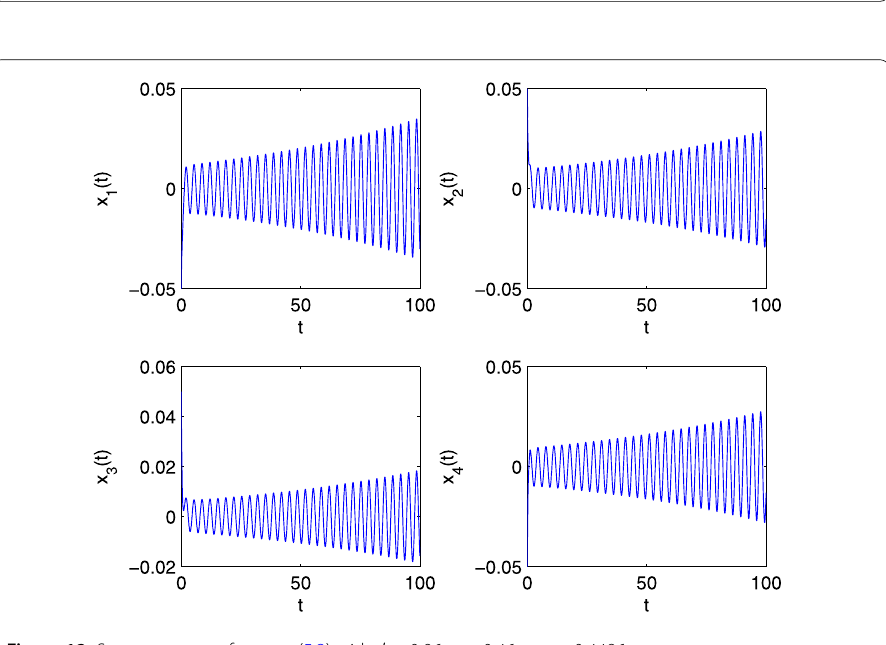
Figure 12 State response of system (5.3) with φ = 0.96, τ = 0.46 > τ 0 = 0.4486